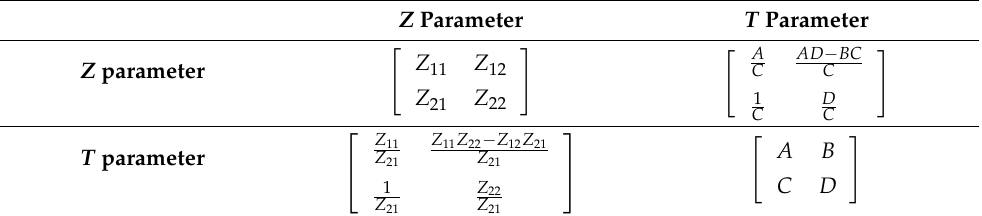
Table 2. Mutual conversion relationship between Z parameters and T parameters. Z Parameter T